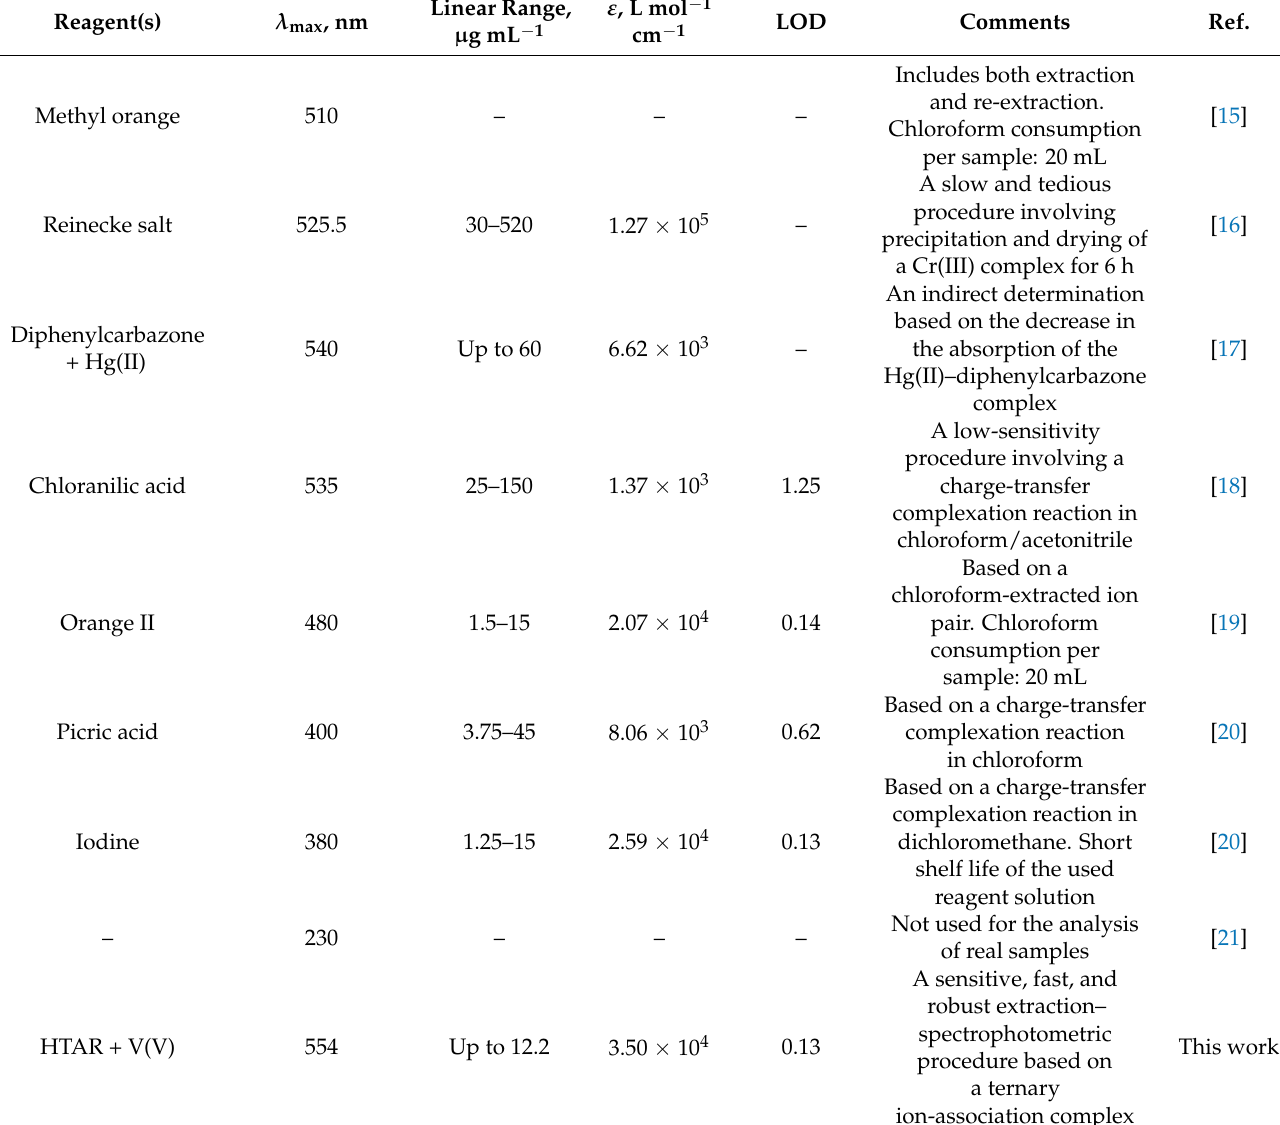
Table 1. Spectrophotometric procedures for the determination of